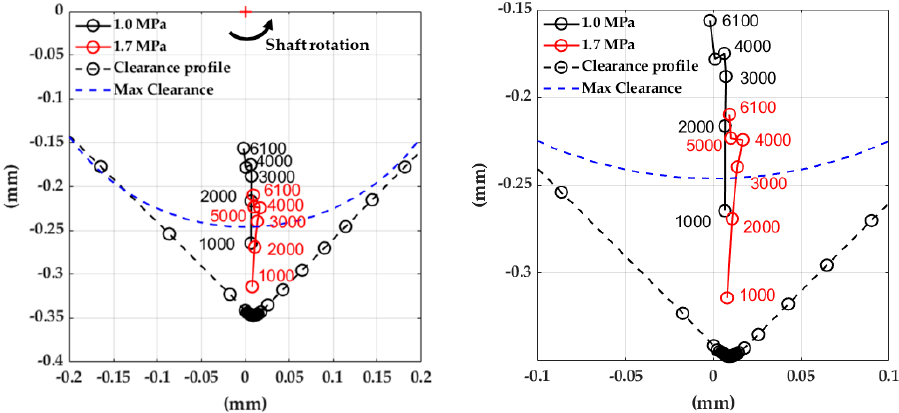
Figure 15. Flooded Ball & Socket Pivot bearing shaft centerline with detail on the right. Table 5. Geometric Shaft Sink.